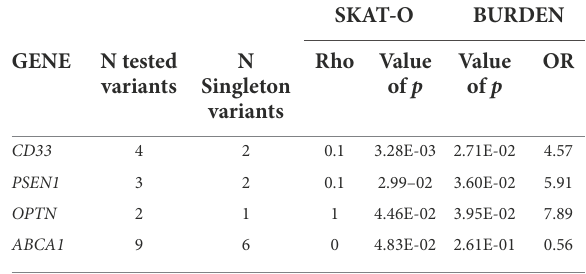
TABLE 4 Genes enriched by rare/low frequency variants after gene- based analysis with a SKAT-O p value